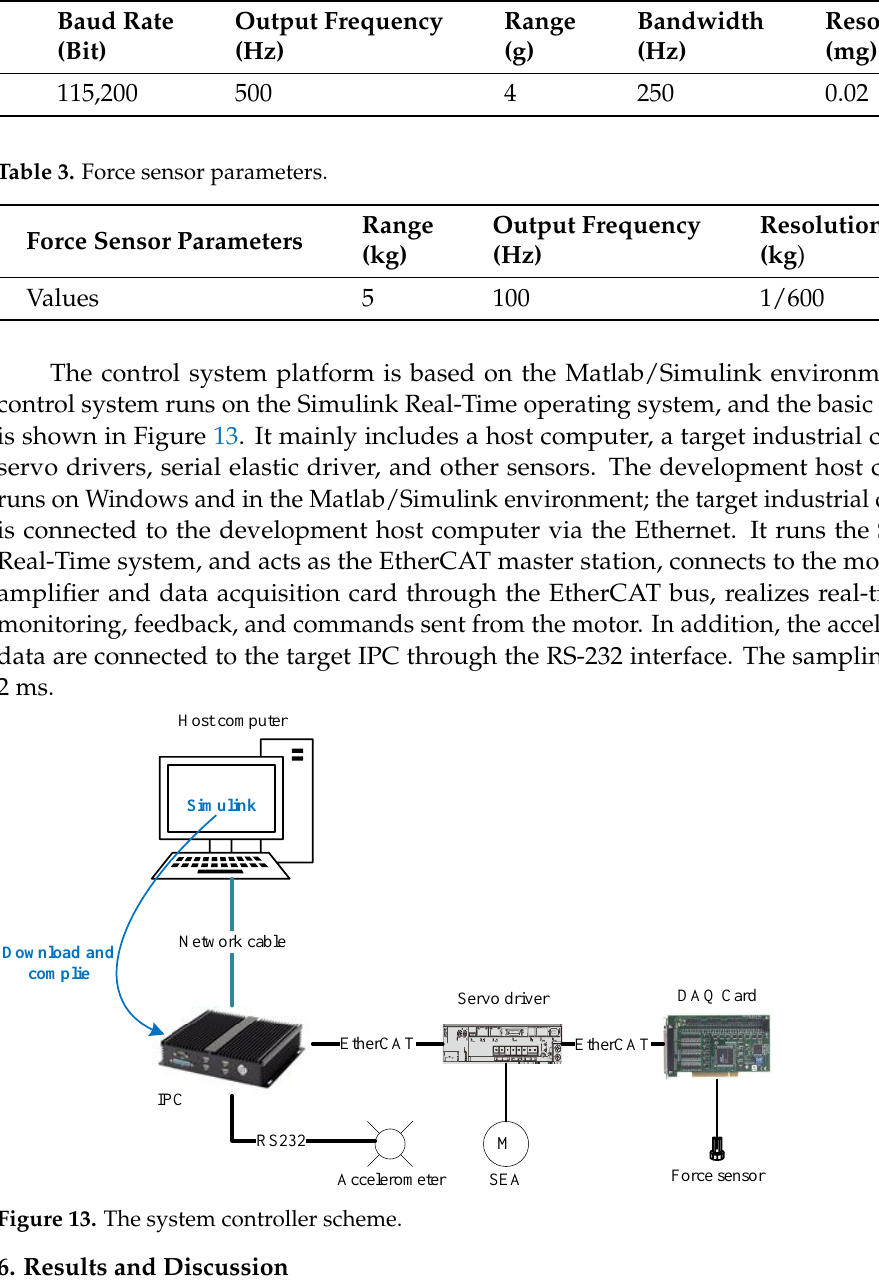
Table 2. Accelerometer parameters.